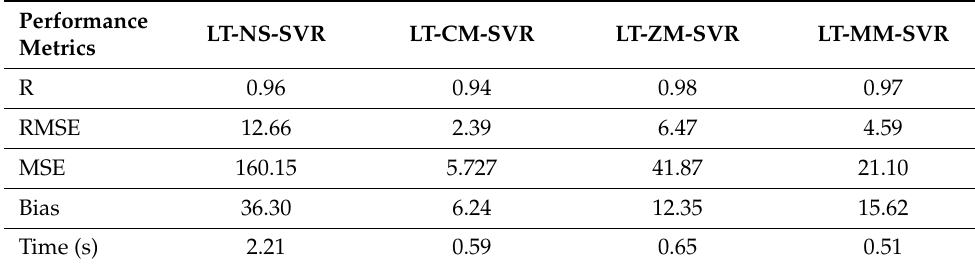
Table 2. Comparison of the performance of Z-score scaling (i.e., LT-ZM-SVR) with other